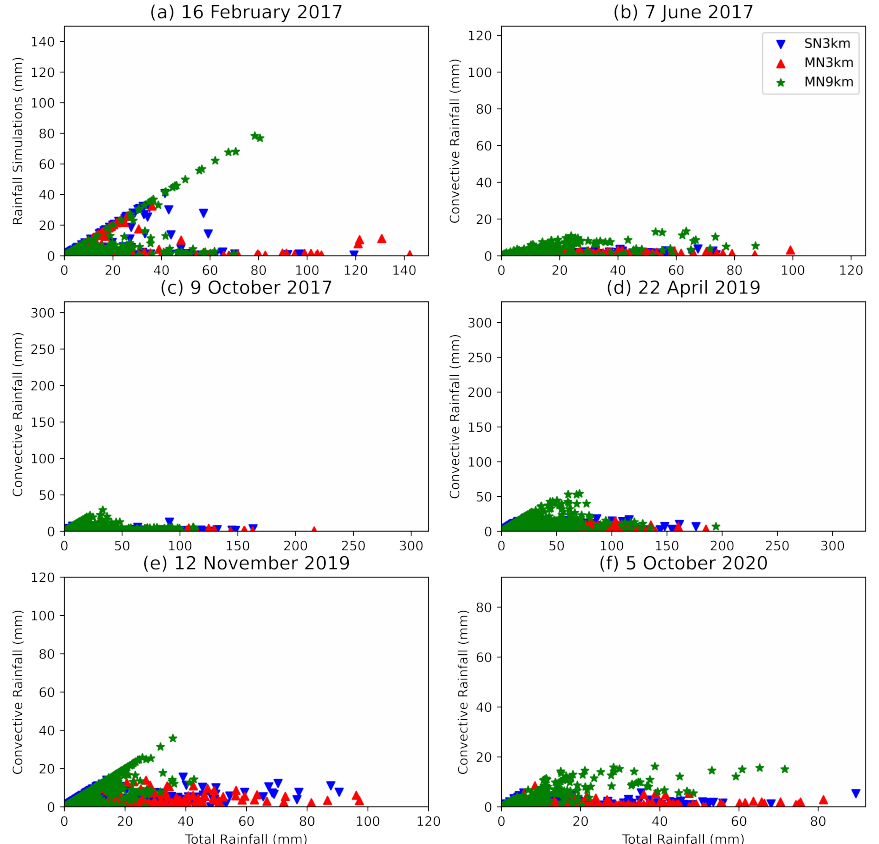
Figure 15. The total simulated rainfall to convective rainfall scatter plot for ( a ) tropical cyclone Dineo, ( b ) the Cape storm, ( c ) the KZN 2017 October floods, ( d ) the KZN 2019 April floods, ( e ) the KZN 2019 tornadoes and ( f ) the Johannesburg floods.